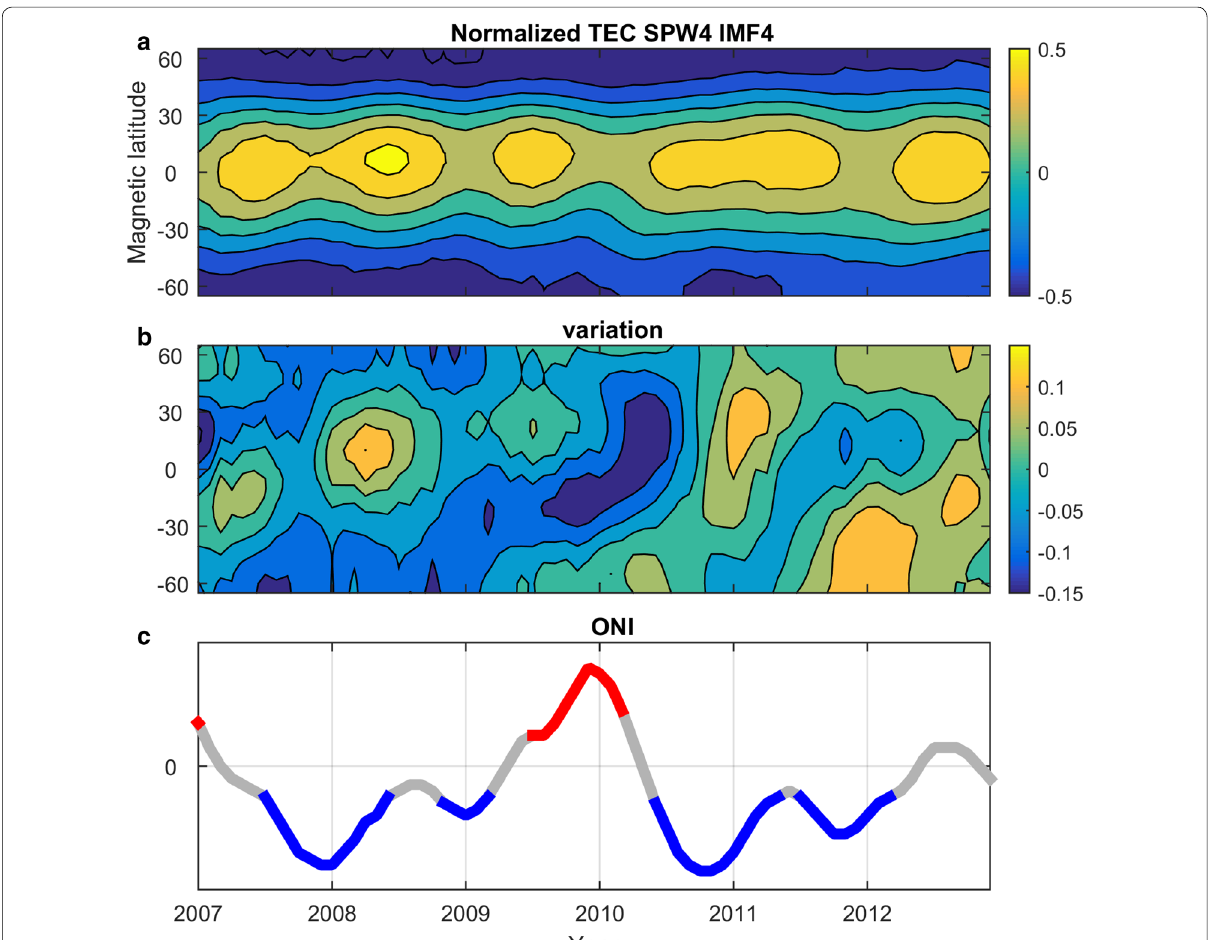
Fig. 3 The response of the annual component (IMF (intrinsic mode function) 4) of the ionospheric TEC (total electron content) SPW4 (stationary planetary wave 4) to ENSO. a Normalized annual component of the SWP4 amplitude. The normalized annual component is defined as the annual component being divided by its long‑term trend at each latitude (seeing details from Chang et al. 2016). b The variation is the departure from the mean annual cycle of the normalized component. c